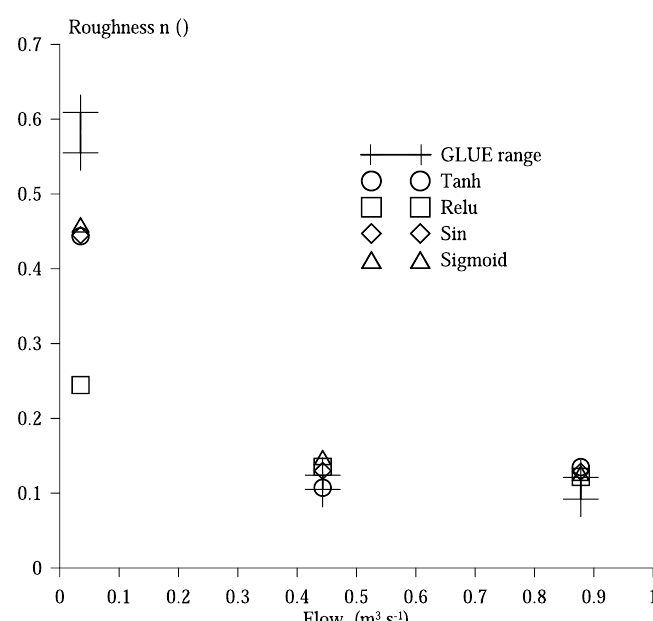
Fig. 8 PINN results with the best case for each activation function for Step‑pool, high flow